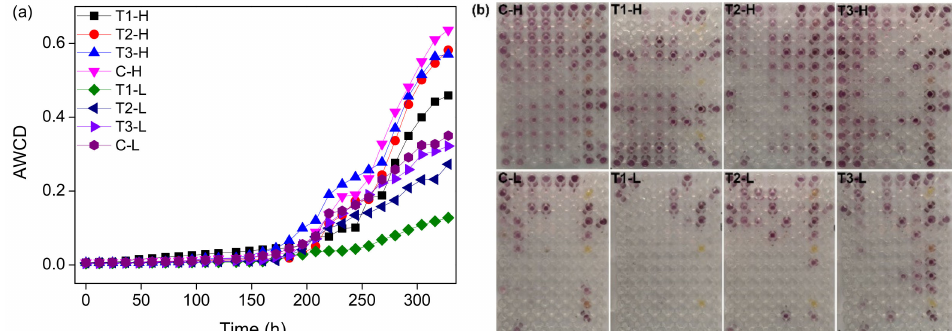
Figure 6. Average well color development (AWCD) of microbial communities cultured in di ff erent treatment groups ( a ) and the colour-reactions of Biolog-ECO plates in di ff erent treatment groups ( b ). The samples numbers are shown in Figure 2.